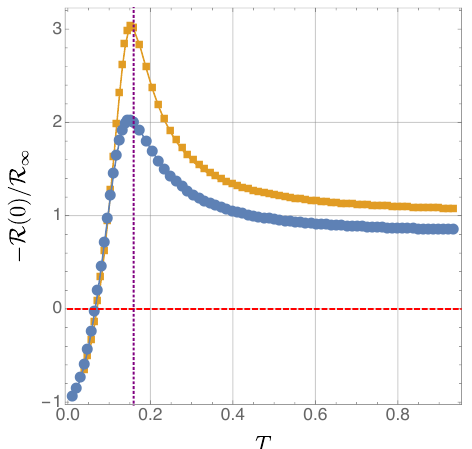
Figure 13 . Induced horizon curvature at the axis of rotation (measured in units of curvature corresponding to a uniform hyperbolic black hole at the same temperature, R 1 = (cid:0) 2 =y 2 function of temperature. The orange squares have (cid:22) = 10, (cid:23) = 4 and the blue disks have (cid:22) = 3 p and (cid:23) = 8 3 = 5. The purple dotted vertical line indicates T = 1 = (2 (cid:25) ) and the red horizon line indicates R =